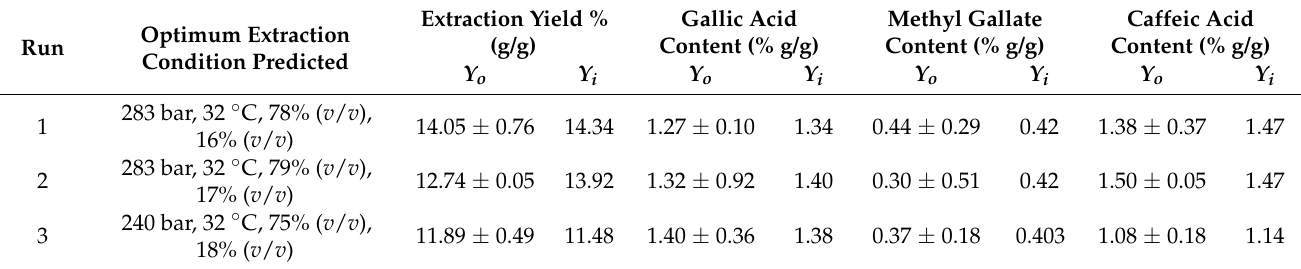
Table 4. Comparison of predicted and experimental optimal values for the response